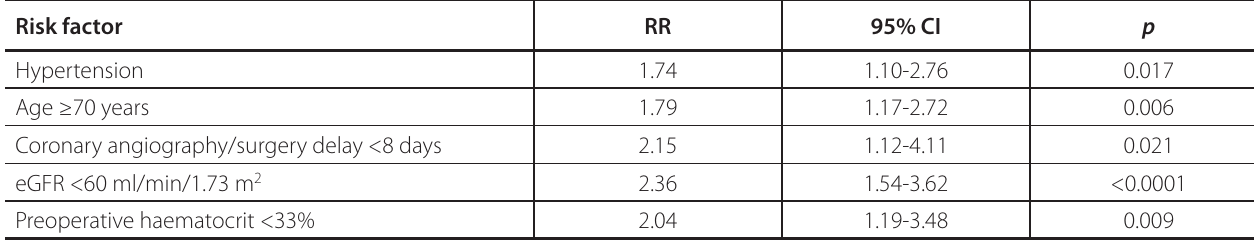
Table 3 . Risk factors for AKI after cardiac surgery in all analysed patients (multivariate analysis).